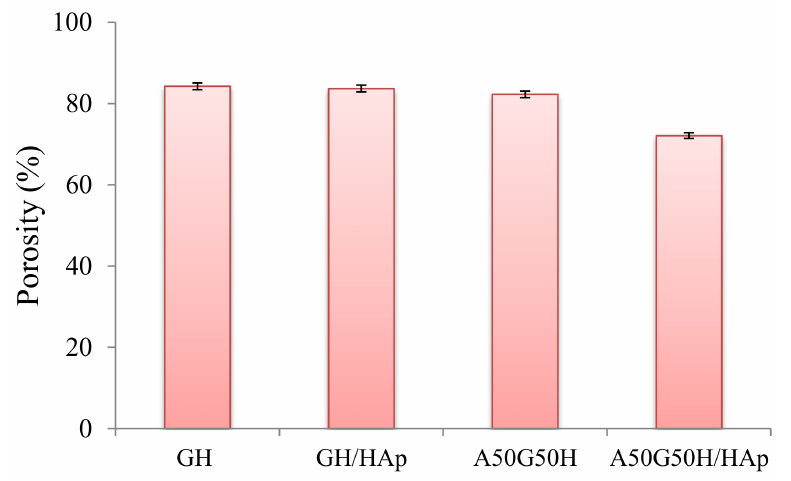
Figure 3. Porosity of hydrogel